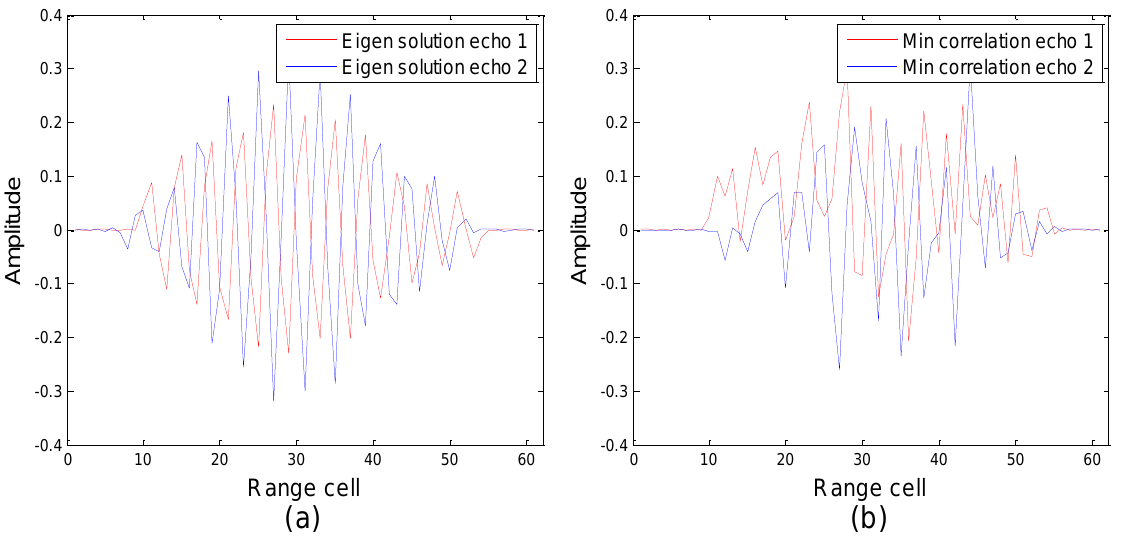
Figure 8. Ideal echoes generated by (a) the eigen-waveform solution and (b) the minimum correlation algorithm in a scenario with only two target hypotheses.